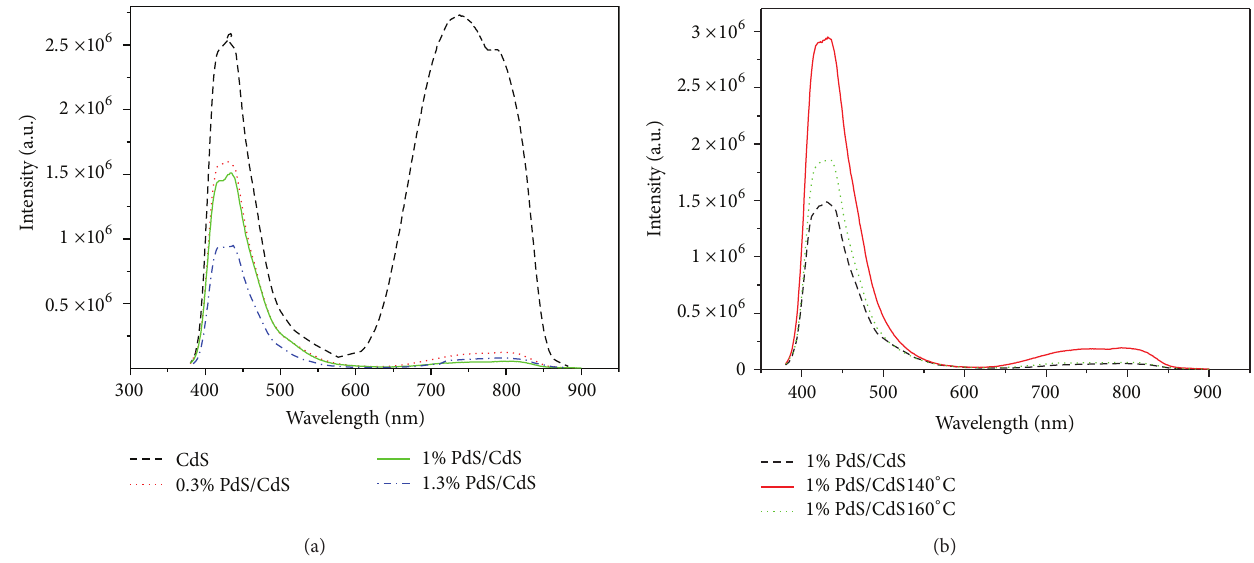
Figure 3: (a) Photoluminescence spectra of PdS/CdS samples loaded with different amounts of PdS. (b) Photoluminescence spectra of PdS/CdS samples loaded with 1wt% PdS prepared by different methods.